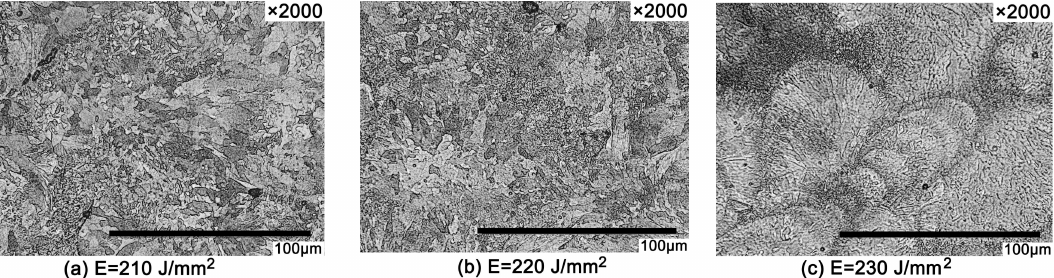
Figure 4. Metallographic morphology at different laser energy densities. ( a ) Metallographic morphology at 210 J/mm 2 laser energy density; ( b ) Metallographic morphology at 220 J/mm 2 laser energy density; ( c ) Metallographic morphology at 230 J/mm 2 laser energy density.